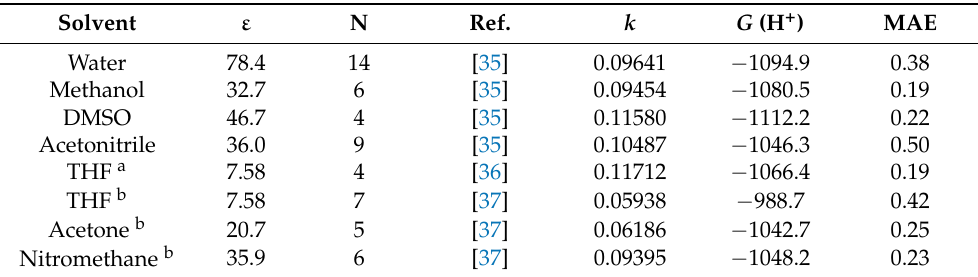
Table 2. Solvent dependence on the scaling factor, k , Gibbs energy of a proton, and mean absolute error (MAE) in computing p K a for aniline derivatives. N indicates the samples of aniline derivatives that have experimental p K a values for the